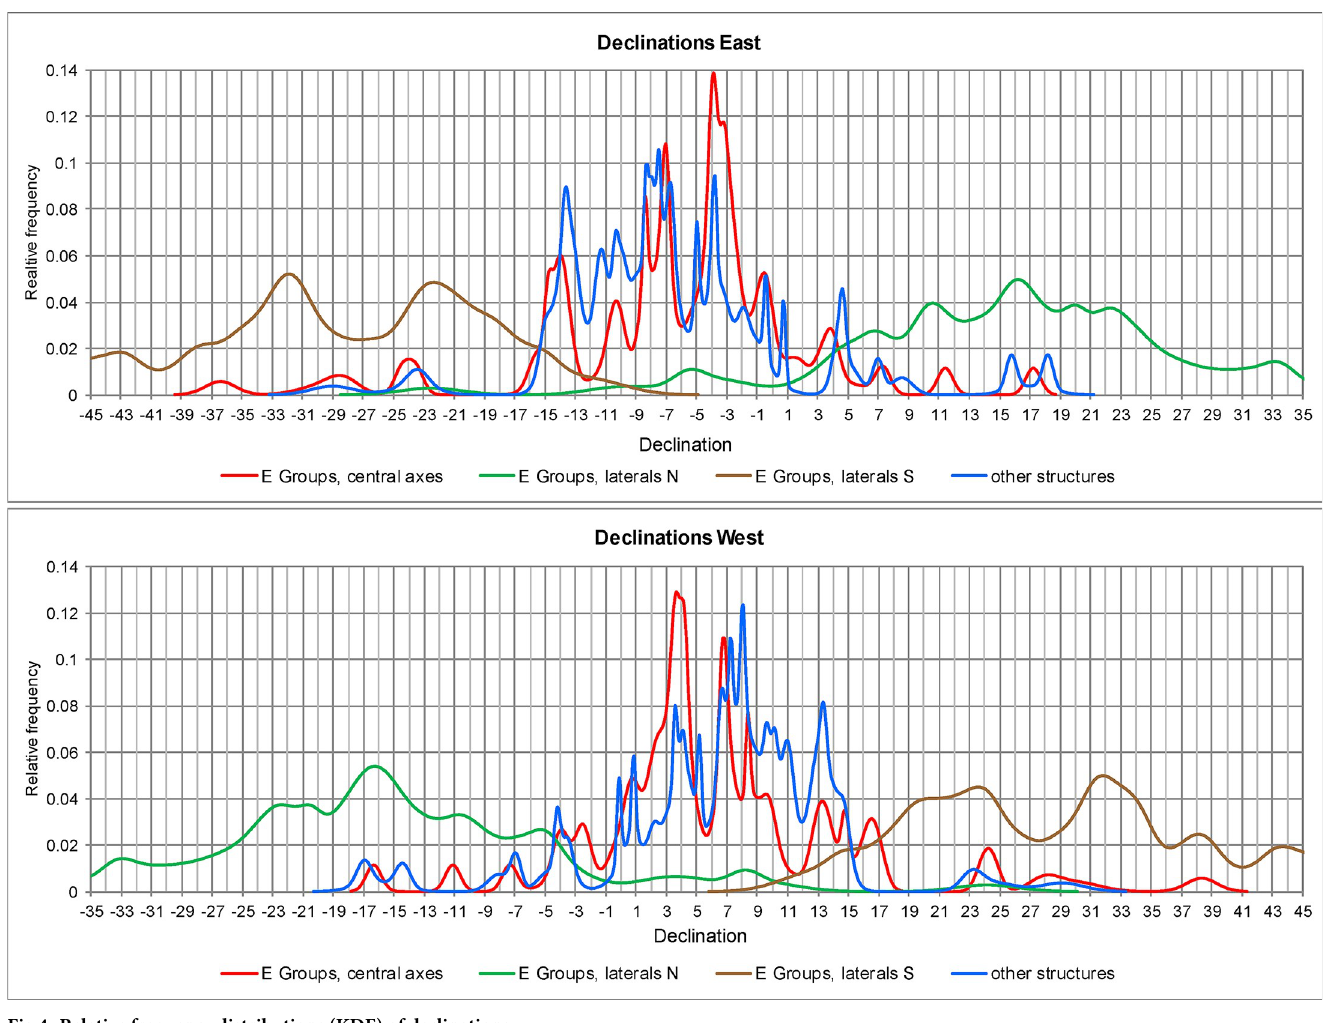
Fig 4. Relative frequency distributions (KDE) of